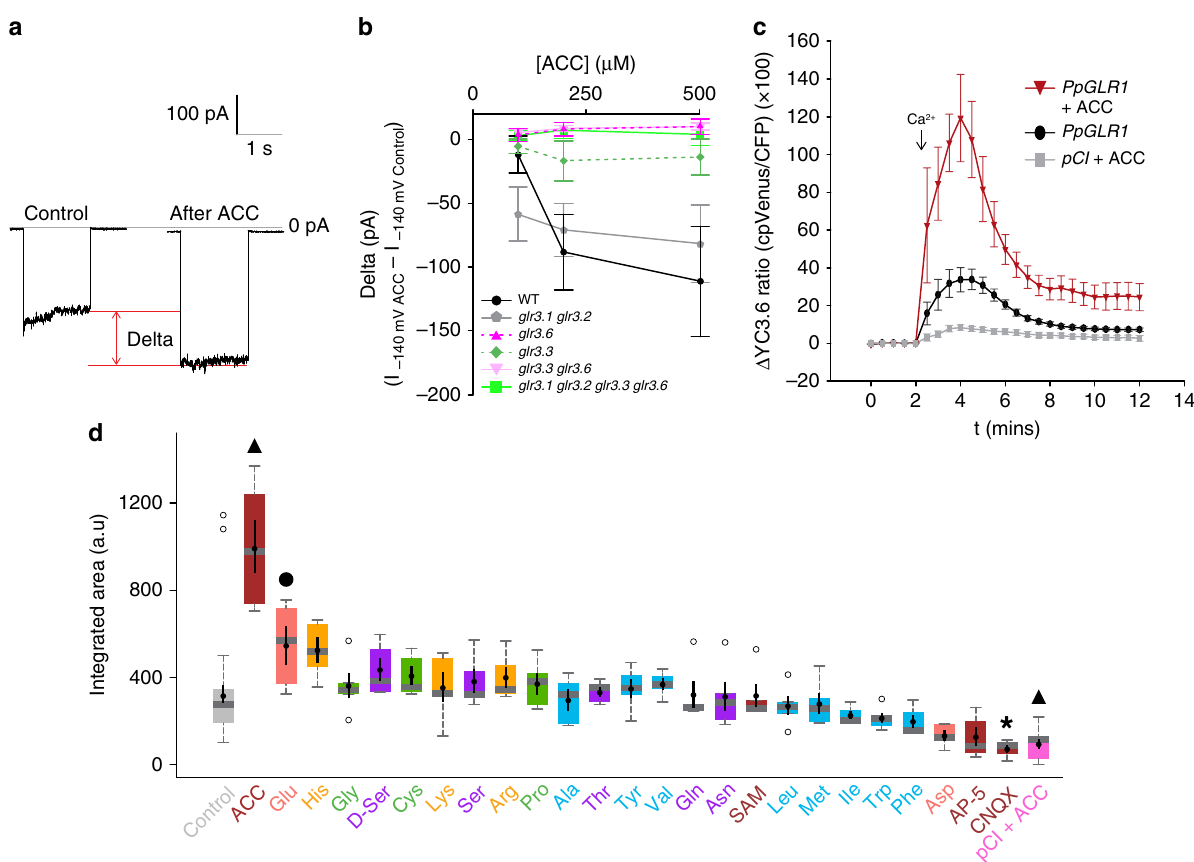
Fig. 3 ACC stimulates GLR-dependent ion transport in Arabidopsis root protoplasts and mammalian COS-7 cells. a Macroscopic currents recorded at − 140 mV under the whole-cell con fi guration in a WT Arabidopsis root protoplast show an increase (delta) after adding ACC (500 μ M) to the bath solution. b Average currents (delta) induced by ACC (100, 200, or 500 μ M) in experiments similar to that in a for root protoplasts of WT and glr knockout mutants. WT and glr3.1 , glr3.2 : n = 5 for 100, 200 μ M ACC, n = 4 for 500 μ M ACC. Quadruple mutant: n = 4 for 100, 200 μ M ACC, n = 3 for 500 μ M ACC. glr3.3, glr3.6 : n = 4 for 100 μ M ACC, n = 5 for 200 and 500 μ M ACC. glr3.3 : n = 4 for all ACC concentrations. glr3.6 : n = 4 for 100 μ M ACC, n = 6 for 200 and 500 μ M ACC. Error bars show ± s.e. c Time course of mean cytosolic Ca 2 + changes in COS-7 cells expressing Pp GLR1 monitored with YC3.6 when applying Ca 2 + (14.5 mM; arrow) to the bath solution in the presence of ACC (500 μ M; red triangles, n = 6) and absence of ACC (black circles, n = 31). Cells transfected with empty vector (pCI) were also treated with ACC (500 μ M; gray squares, n = 10). Statistical signi fi cance was determined between the mean of each curve by two-way ANOVA ( Pp GLR1 + ACC vs. Pp GLR1: P < 0.0001; Pp GLR1 + ACC vs. pCI + ACC: P < 0.0001; Pp GLR1 vs. pCI + ACC: P < 0.0001. F = 50.74, df = 2). Error bars show± s.e. d Comparison of ACC to the 20 proteinogenic amino acids based on Ca 2 + imaging in COS-7 cells expressing Pp GLR1 and YC3.6 as in c . Box plots show changes in cytosolic Ca 2 + evaluated by the integrated area under the YC3.6 response curve for each amino acid (top of box is 75th percentile; bottom of box is 25th percentile; horizontal gray bar is median; gray whiskers show the maximum and minimum value within 1.5× the interquartile range) with outliers (open circles) and mean (solid black circles)± s.e. Included are two candidate ligands, D-Serine (D- Ser) and the ACC precursor S-adenosyl-L-methionine (SAM), and two classic iGluR antagonists, 2-amino-5-phosphonovalerate (AP-5) and 6-cyano-7- nitroquinoxaline-2,3-dione disodium salt hydrate (CNQX). n = 31 for pCI- Pp GLR1 control (no amino acid added), n = 6 for pCI- Pp GLR1 + ACC, n = 10 for pCI (empty vector) + ACC, n = 5 for all other treatments. Statistical signi fi cance was determined using Dunnett ’ s test (solid black circle P < 0.1, * P < 0.05, solid black triangles P <